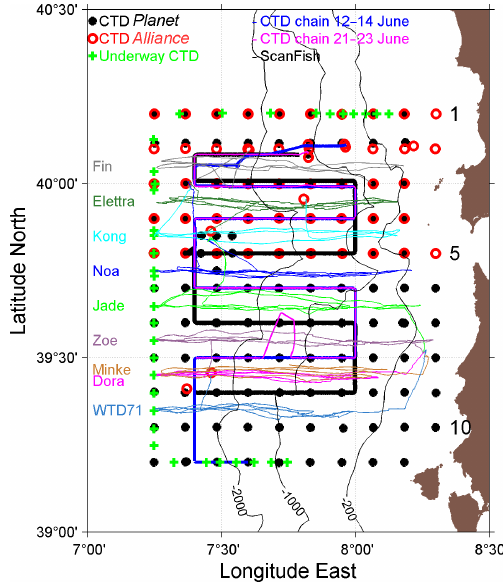
Figure 1. CTD data sets obtained with different instruments. Glider names are specified next to their tracks. For reference, zonal CTD transects 1, 5, and 10 are also marked. Thin black lines denote the 200, 1000, and 2000m isobaths.